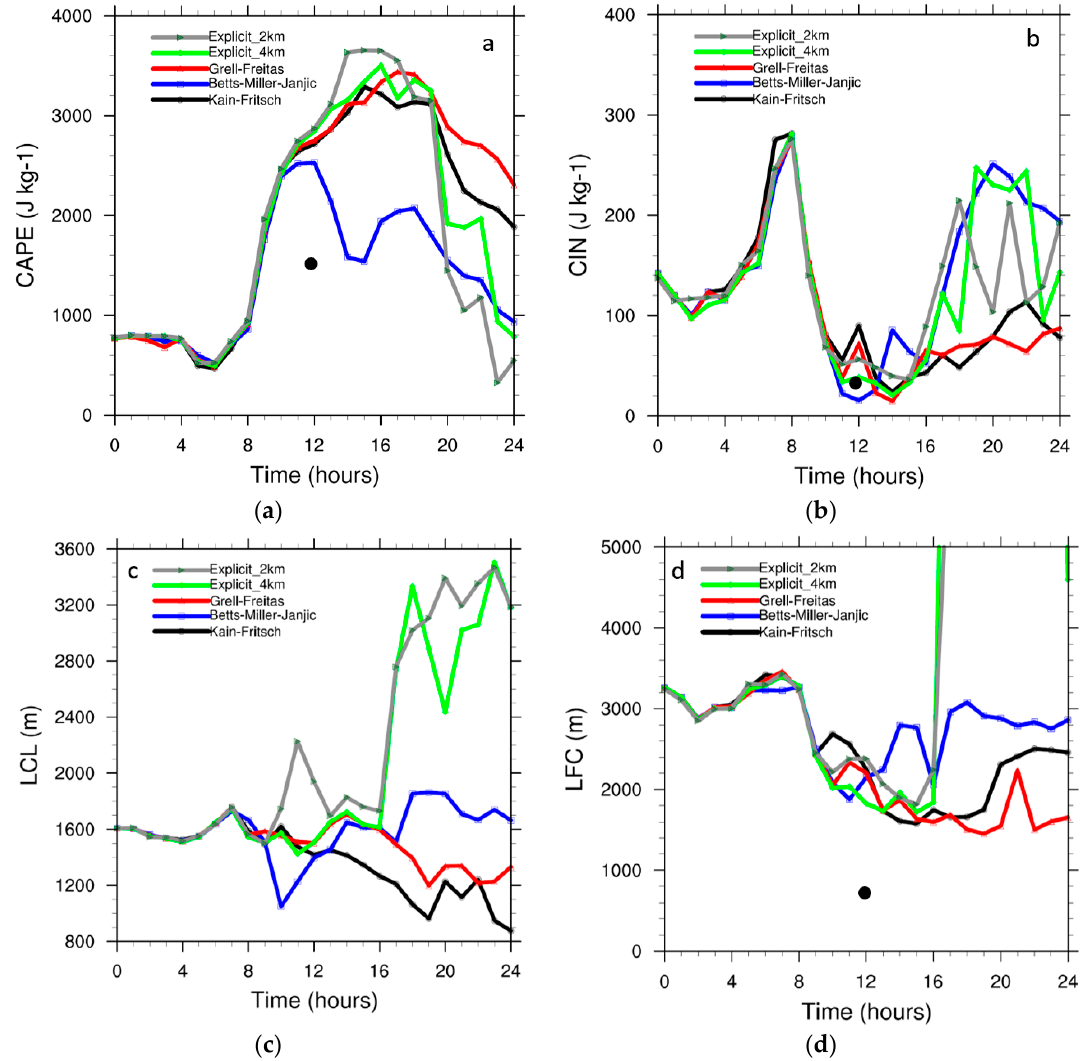
Figure 5. Modelled time evolution of ( a ) Convective Available Potential Energy (CAPE) (J kg − 1 ), ( b ) Convective Inhibition (CIN) (J kg − 1 ), ( c ) Lifting Condensation Level (LCL) (m) and ( d ) Level of Free Convection (LFC) (m) for Kain–Fritsch; Betts–Miller–Janjic; Grell–Freitas, explicit 4 km and explicit 2 km configurations for the location Eindhoven. The black dot indicates the observed CAPE value from the 12 UTC sounding.